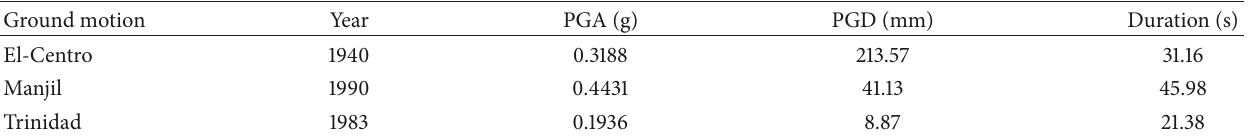
Table 3: Selected ground motion